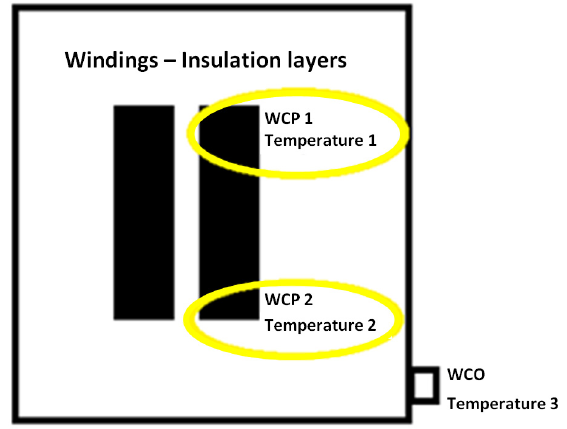
Figure 17. Temperatures for calculating water content in solid insulation.